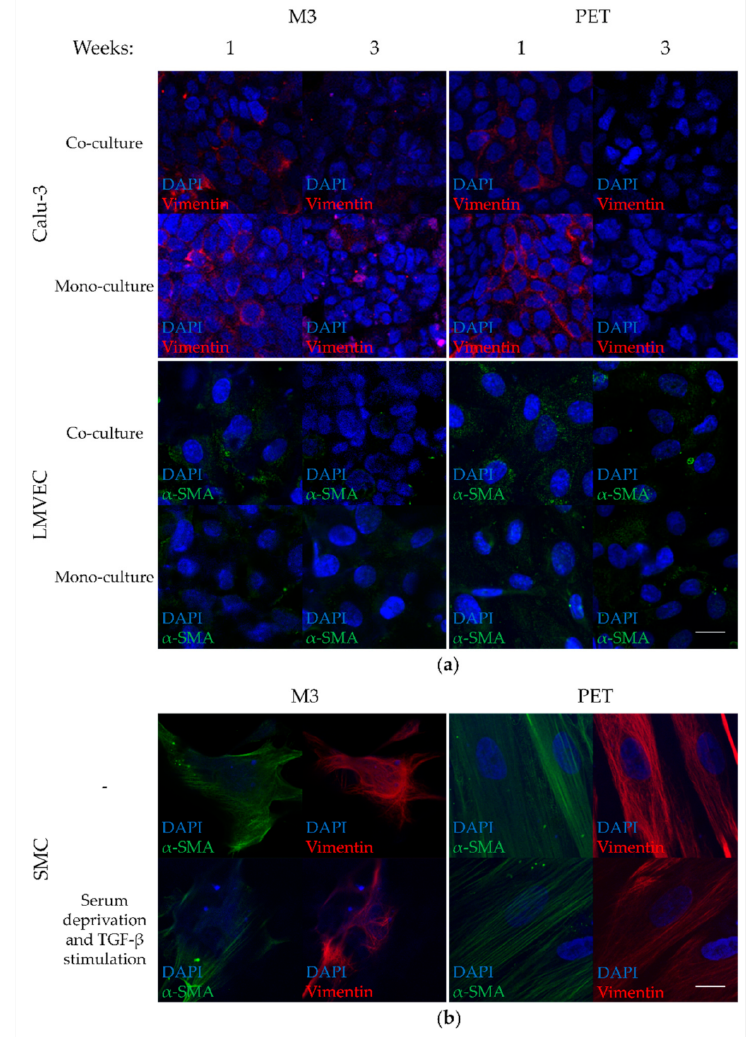
Figure 5. Staining for epithelial-to-mesenchymal (EMT) and endothelial-to-mesenchymal (EndoMT) markers of cells on M3 and PET membranes. ( a ) Co- and mono-cultures of Calu-3 cells and LMVECs were cultured in inserts on M3 or PET membranes. Cells were cultured submerged for 1 week, after which they were either fixed or cultured for 2 additional weeks (at ALI in the case of Calu-3 cells) and fixed. Calu-3 cells were stained for the cell nucleus (blue) and vimentin (red). LMVECs were stained for the cell nucleus (blue) and α -SMA (green). Magnification: 1600 × . Scale bar: 20 µ m, applies to all images. ( b ) SMCs were stained as positive controls for mesenchymal marker expression. They were grown submerged for 5 days on M3 or PET membranes. Some cells were then serum-deprived and stimulated with transforming growth factor β (TGF- β ). All samples containing human smooth muscle cells (SMCs) were fixed on day 8. SMCs were stained for the cell nucleus (blue), α -SMA (green), and vimentin (red). Magnification: 1600 × . Scale bar: 20 µ m, applies to all images. Images are representative for observations of multiple samples from one experiment (total N =